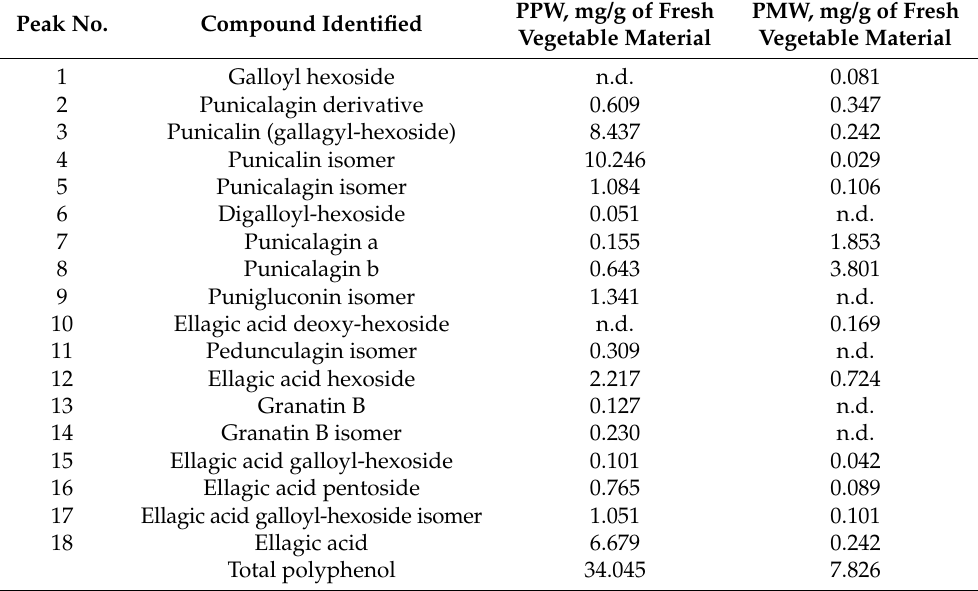
Table 2. Total polyphenol amount, as measured by HPLC, in the pomegranate byproduct matrices analyzed in this study. Results are reported as mg of compound per gram of fresh vegetable material and as the mean of three replicates. PPW = pomegranate peel water extract; PMW = pomegranate mesocarp water extract; n.d. = not detected. See text for further details. PPW, mg/g of Fresh PMW, mg/g of Fresh Peak No. Compound Identified Vegetable Material Vegetable Material 1 Galloyl hexoside n.d. 0.081 Punicalagin derivative 0.609